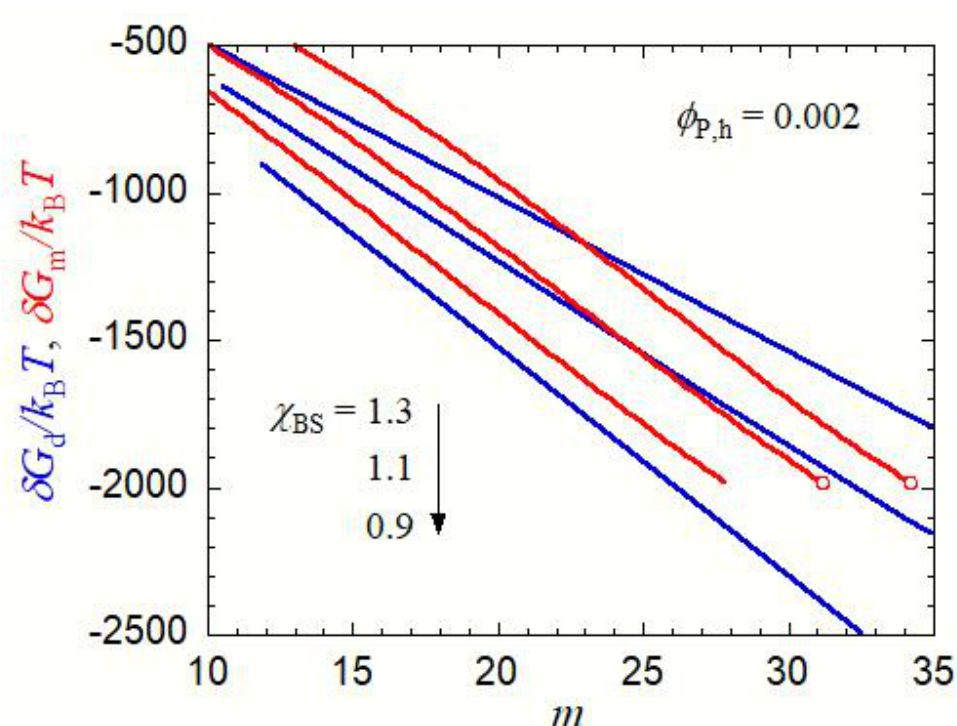
Figure 4. Gibbs energy of the droplet formation δ G d (blue curves) and the Gibbs energy of the micelle formation δ G m (red curves) in the copolymer solution with P A = P B = 100, χ AS = 0.4, χ AB = 0, and χ BS = 1.3, 1.1, and 0.9 at φ P,h = 0.002, as functions of the aggregation number m . Red circles indicate the points corresponding to the equilibrium micelle, fulfilling Equations (13 a ) and (13b).